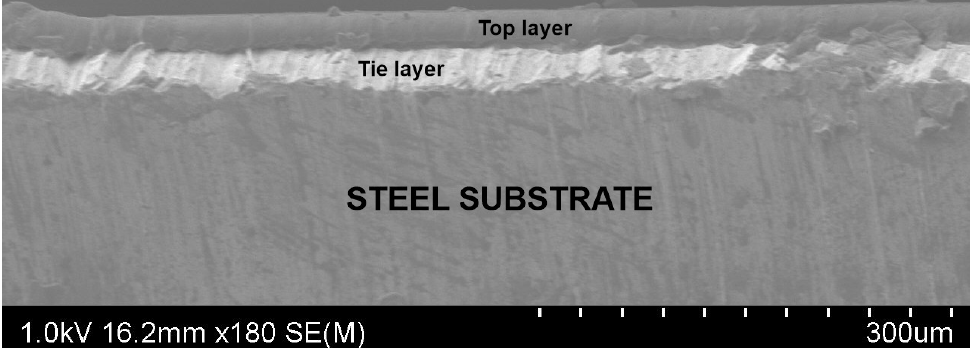
Figure 4. SEM image of the material.